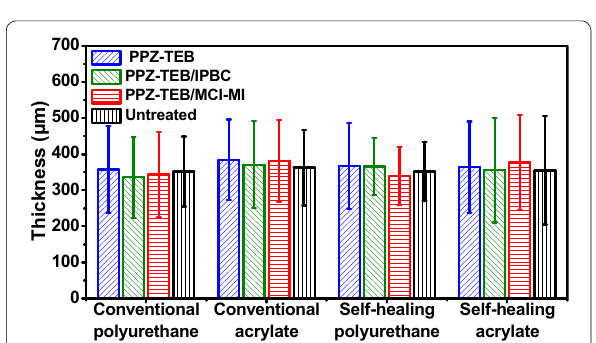
Conventional Conventional Self-healing Self-healing polyurethane acrylate polyurethane Fig. 8 Damaged area of coatings. Error bars represent the standard